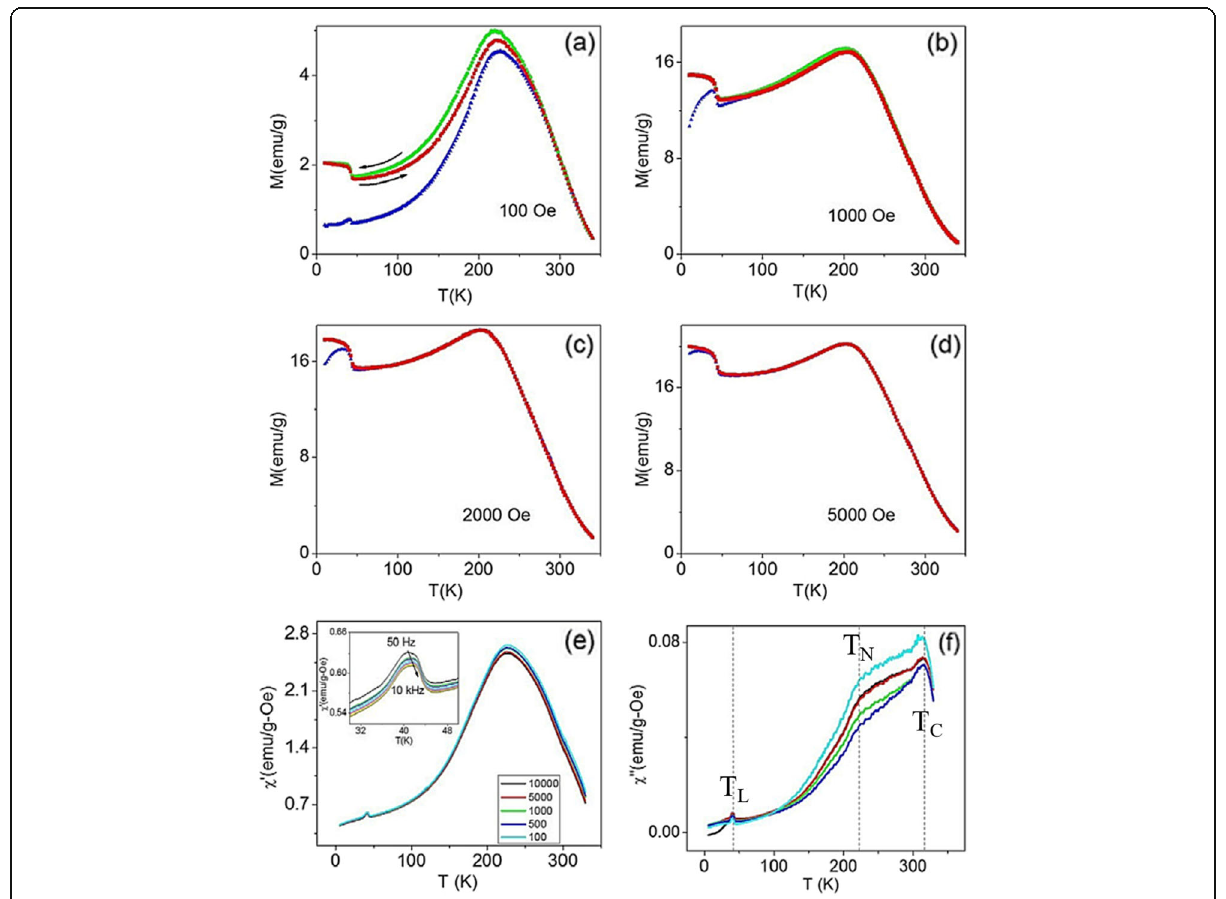
Fig. 29 a , b Zero-field-cooled (ZFC) (blue), field-cooled-cooling (FCC) (green), and field-cooled-warming (FCW) (red) magnetization curves of the La 0.5 Sr 0.5 MnO 3 nanowires measured under applied fields of a 100 Oe and b 1000 Oe. c , d ZFC and FCW magnetization curves obtained under applied magnetic field of c 2000 Oe and d 5000 Oe. e Real and f imaginary parts of linear ac susceptibility versus temperature plots for different frequencies. The inset of ( e ) shows a magnified view of χ ’ (T ) for more frequencies. Reproduced with permission of